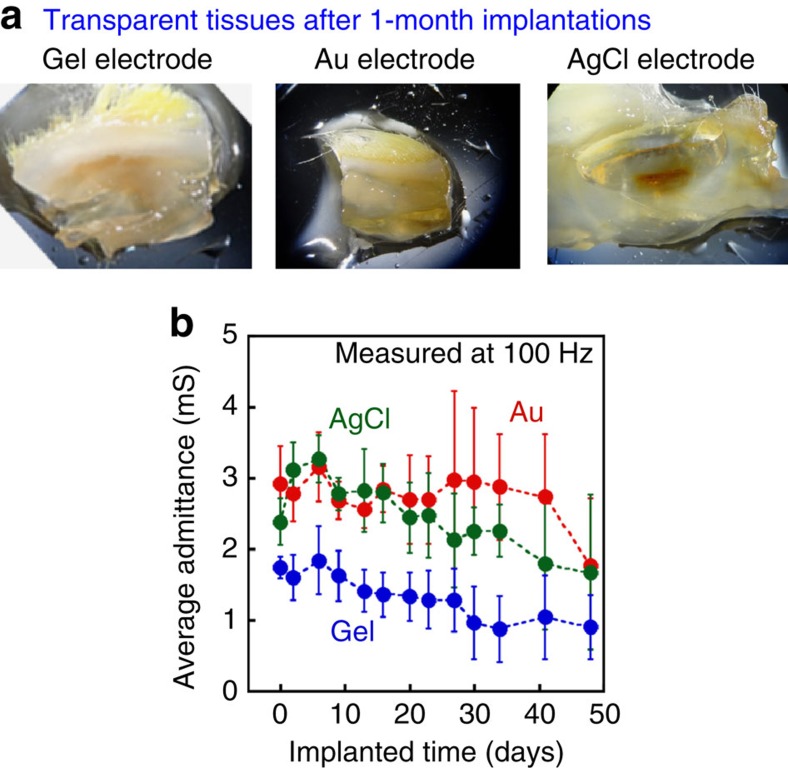
Biocompatibility test 2.(a) Samples (pathology grafts) are transferred to the final clearing solution (LUCID: nine parts thiodiethanol and one part glycerol) at room temperature. The cleaned tissues are evaluated using microscopy. Internal haemorrhage is observed in the pathology grafts where the AgCl electrode is explanted. (b) Averaged conductance of electrodes subcutaneously implanted in living rats, whose details can be seen in Supplementary Fig. 9.